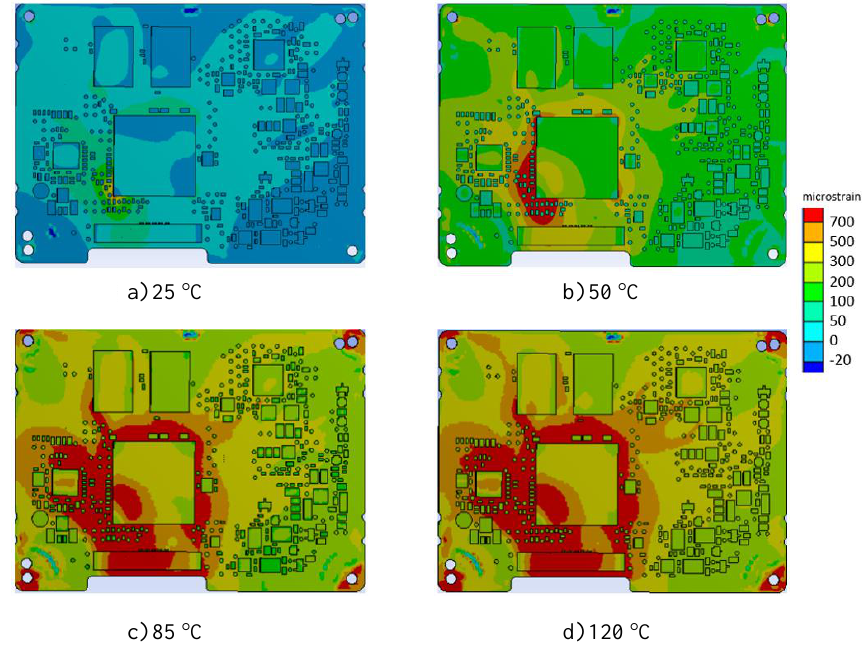
Figure 10. Principal strain obtained by finite element method: ( a ) 25 °C; ( b ) 50 °C; ( c ) 85 °C; ( d ) 120 °C. The strain maps highlight an increase in strains around the microprocessor (the biggest component on the PCB). The numerical analysis showed that the maximum allowable limit of 700 μ strains [6] was exceeded in both areas (0 and 1) at 85 °C.